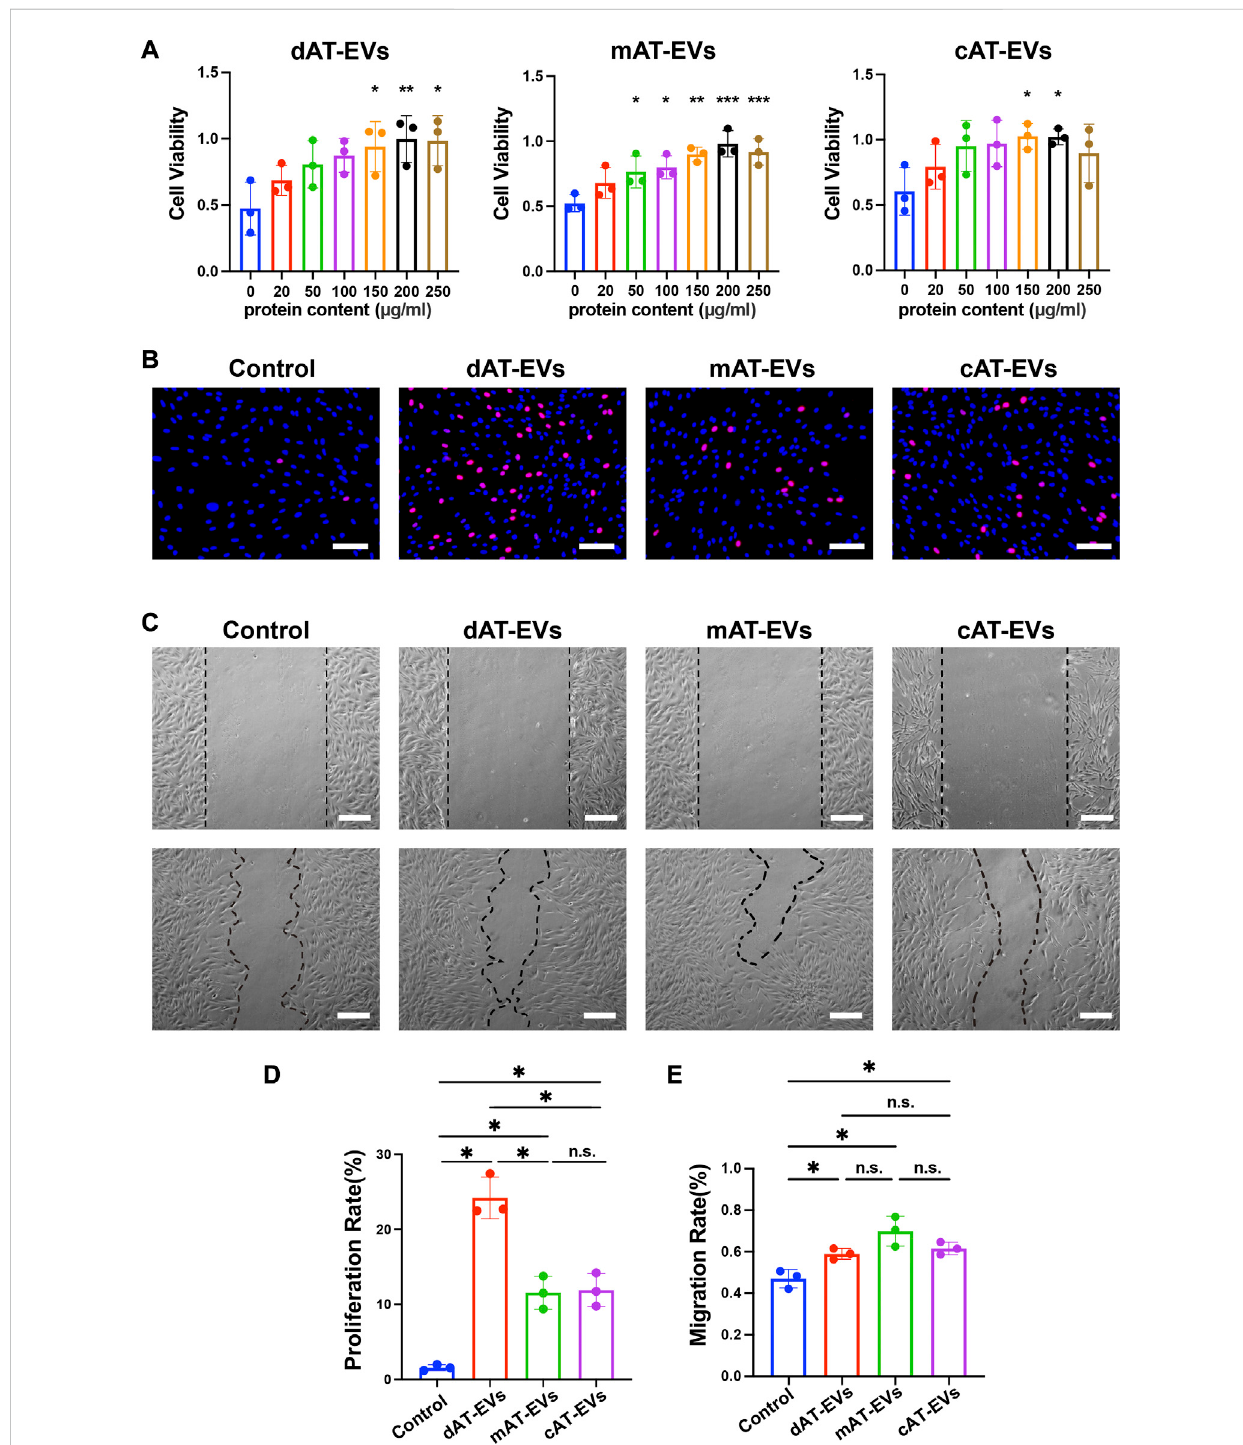
FIGURE 4 AT-EVs promoted cell activity, proliferation, and migration of HDFs in vitro (A) Cell viability of HDFs incubated with different concentrations of AT- EVs for 72 h ( n = 3). (B) Cell proliferation determined using the EdU assay; EdU-positive HDFs (red) and nuclei (blue) were observed by fl uorescence microscopy;scalebar=100 μ m. (C) MigrationofHDFsafterincubationwith150 μ g/mLAT-EVs24 h(n=3).Scalebar=250 μ m. (D) Statisticalanalysisof HDFs ’ proliferation rate ( n = 3). (E) Statistical analysis of HDFs ’ migration rate ( n = 3). n. s. no signi fi cant difference observed between groups. * p < 0.05, ** p < 0.01, *** p <